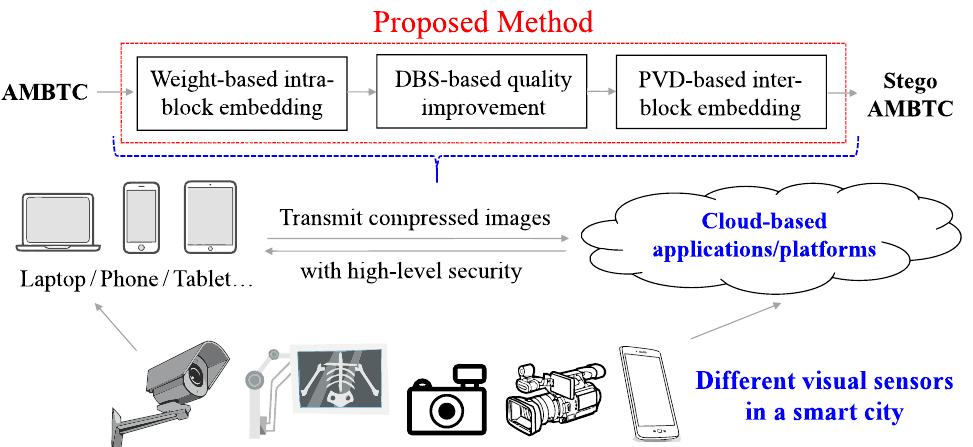
Figure 1. Conceptual framework and the application scenario which illustrate the usage of the proposed method. In a smart city, the proposed method can perform data-hiding and compression jointly to increase the security level of visual sensing data.